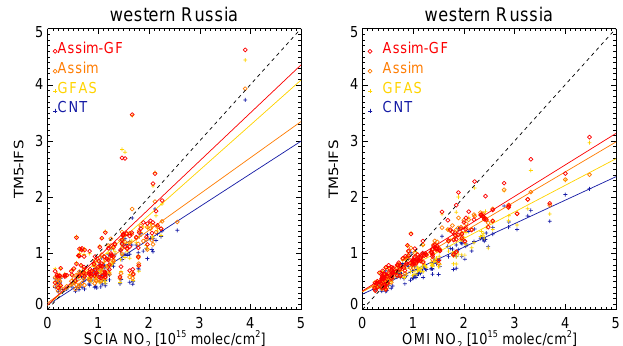
Fig. 13. Time series of modeled tropospheric NO 2 columns (hind- cast D+0) against SCIAMACHY (left) and with averaging kernel against OMI NO 2 from DOMINO v2.0 (right).